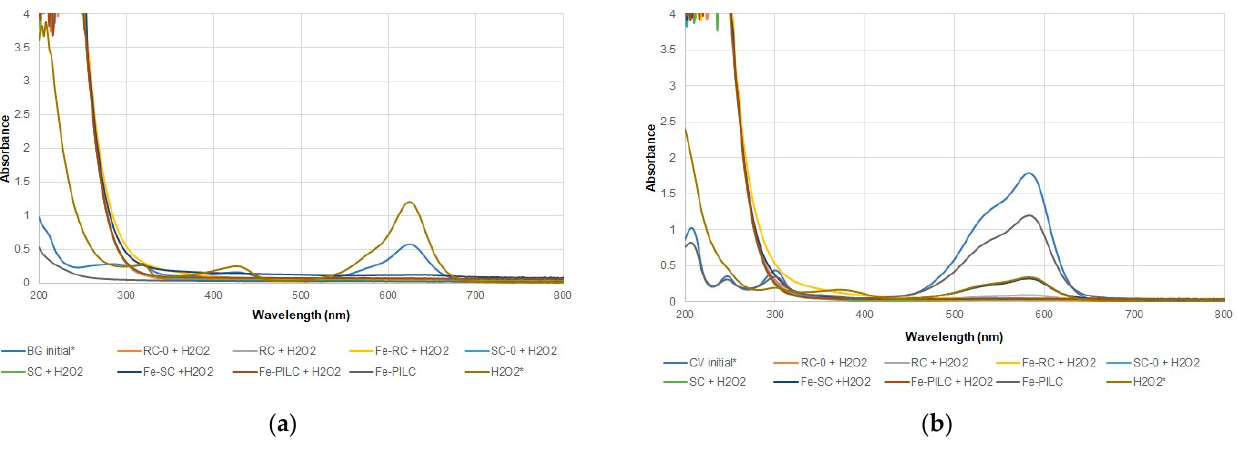
Figure 6. Absorption UV-Vis spectra changes at the end of CWPO process for BG ( a ) and CV ( b )— 100 mg/L initial concentration (* indicates a dilution coefficient of 10). Table 2. Efficiency values for CWAO and CWPO process (100 mg/L dye concentration).